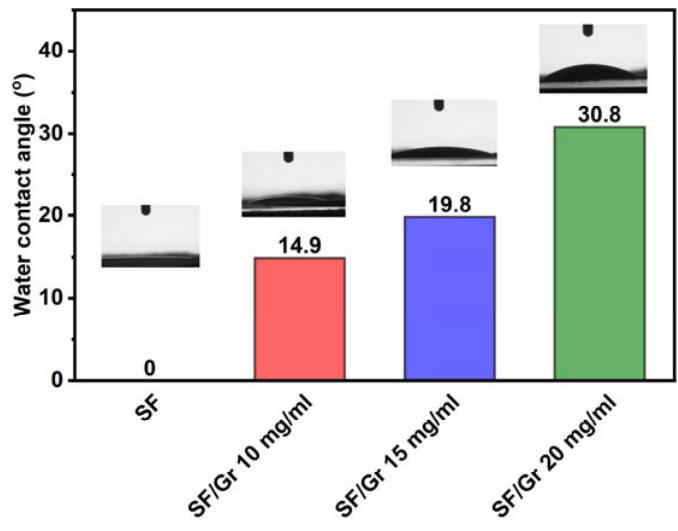
Figure 3. The water contact angle of nanofiber membranes.